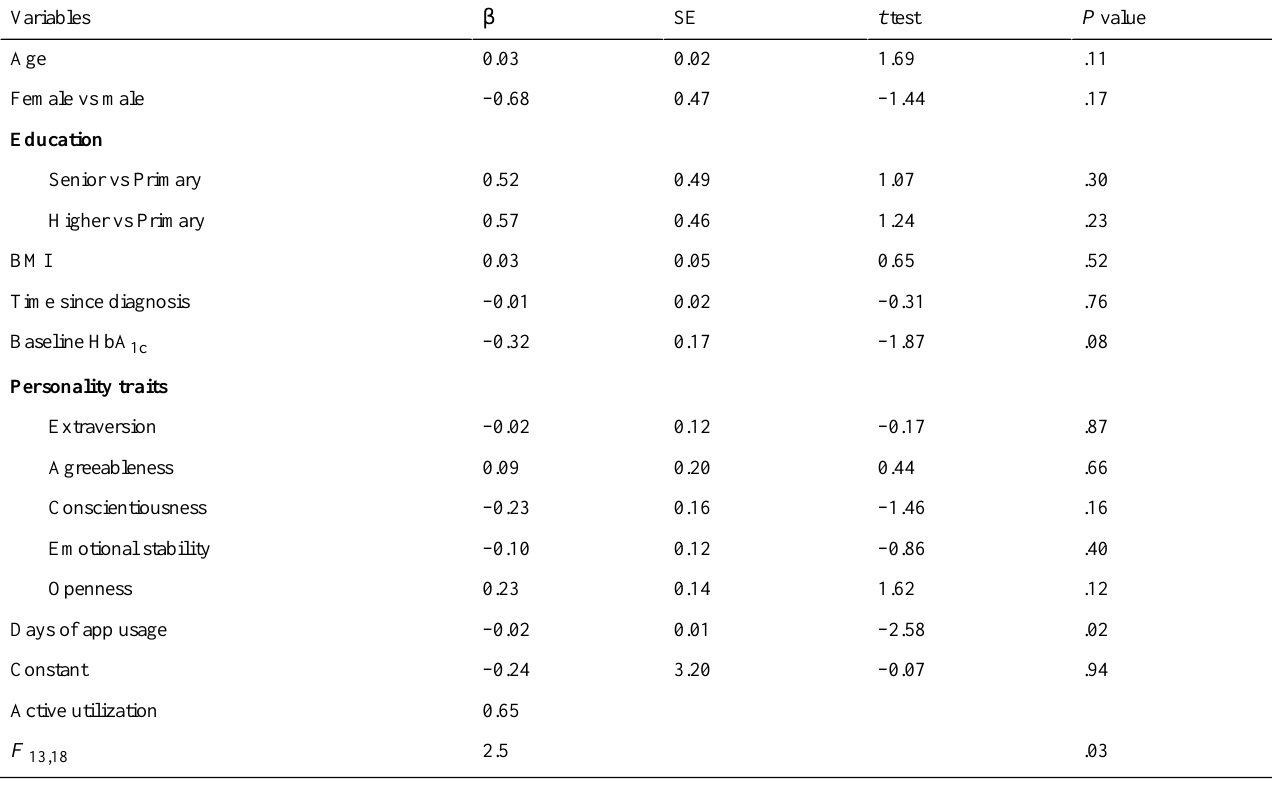
Table 5. Model estimates predicting Δ HbA 1c for adopters